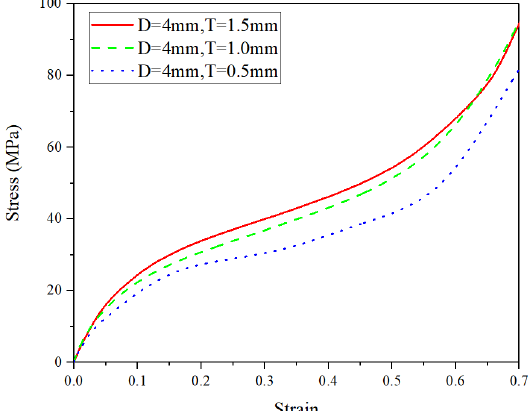
Figure 16. Stress–strain curves of the uniform CCCFs with the same pore diameter but a different wall thickness ( t = 0.5 mm, 1 mm, and 1.5 mm).